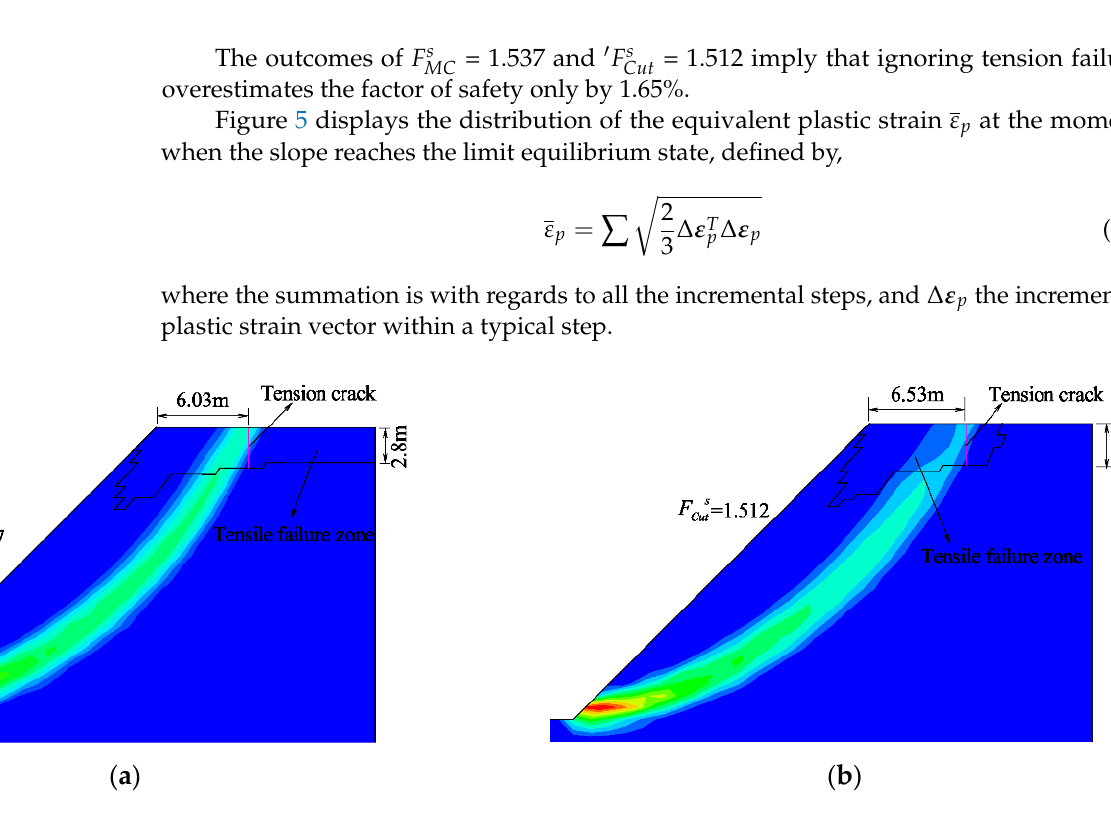
Figure 4. Geometry and adopted mesh. ( a ) geometry; ( b ) adopted mesh.